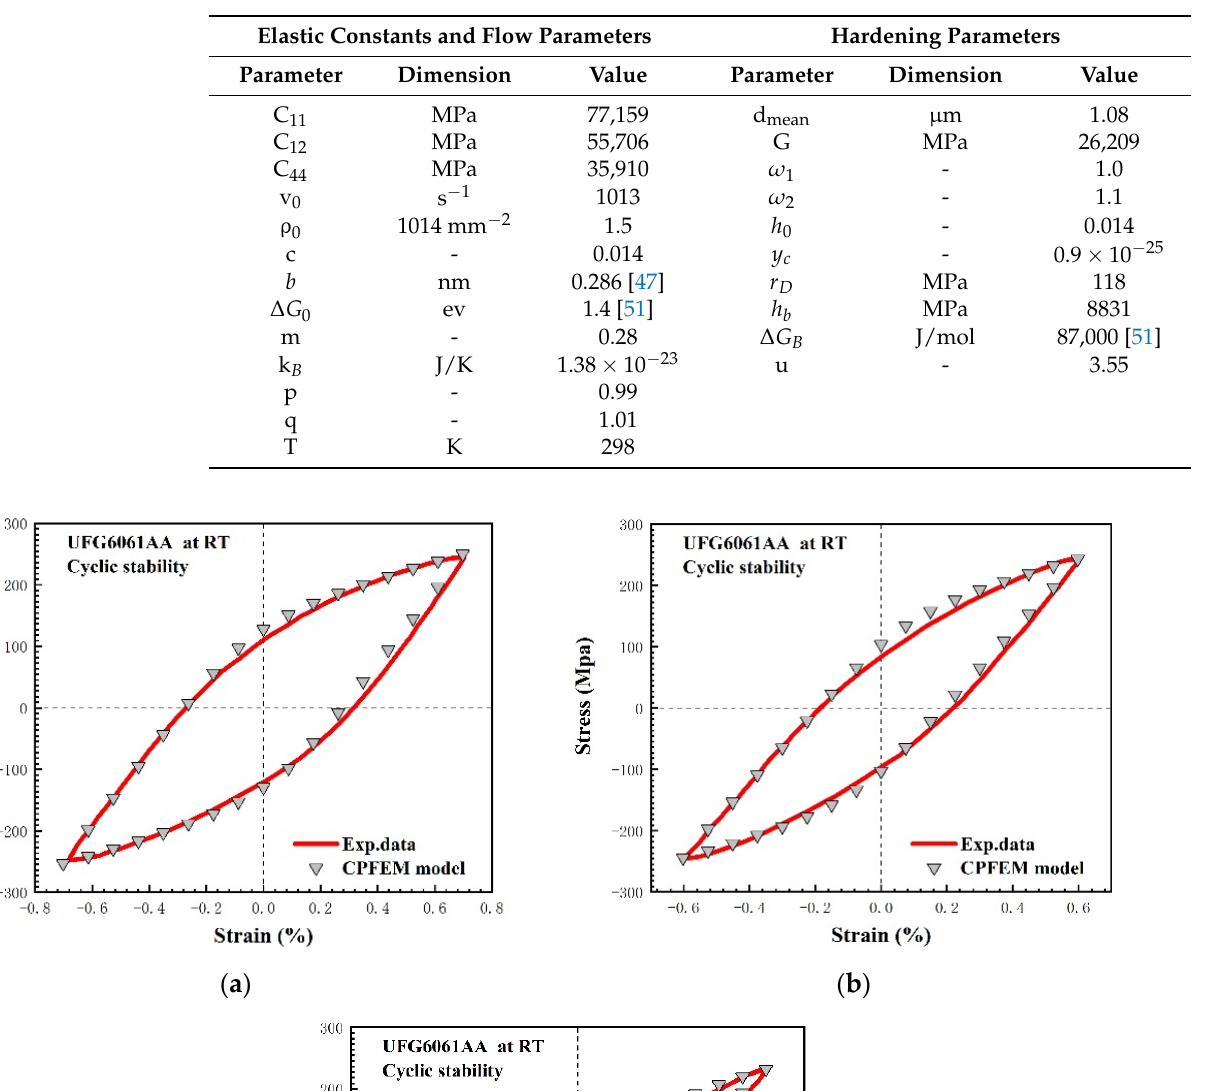
Table 2. Material parameters for CPFEM simulation.